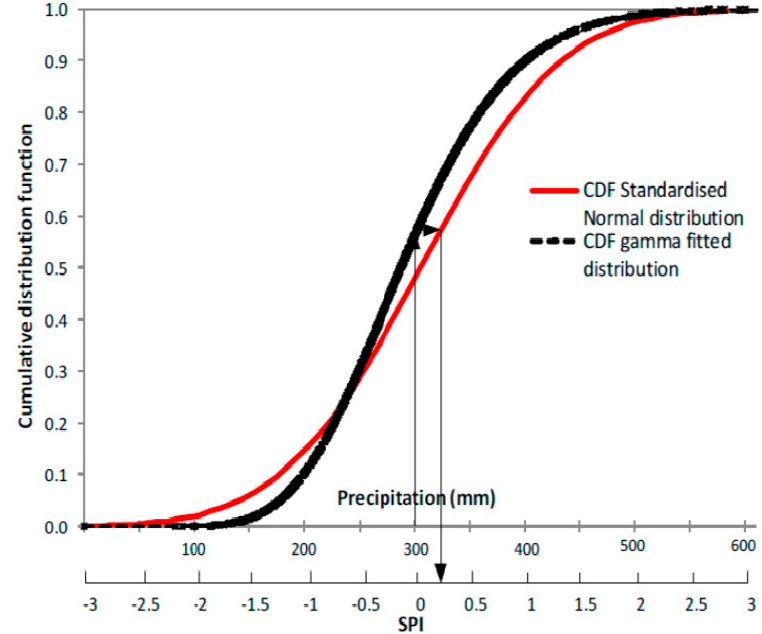
Figure 2. The probability transformation from fitted gamma distribution to the standard normal Figure distribution.